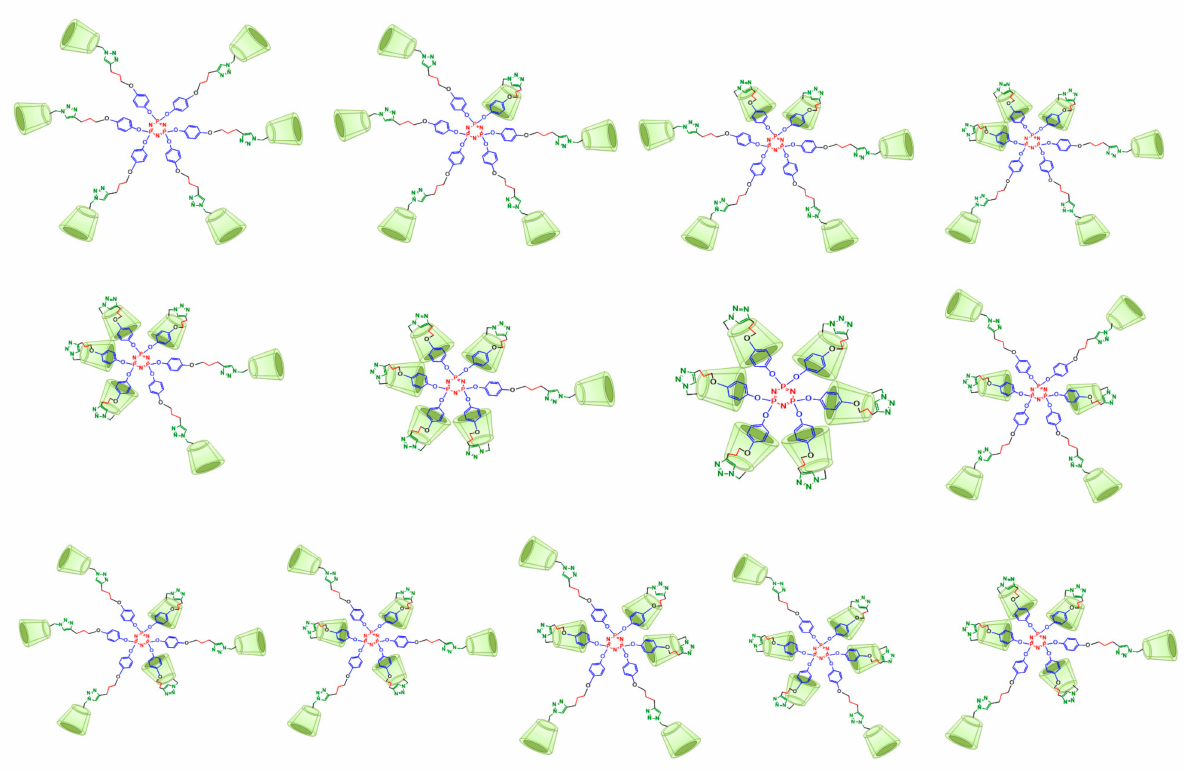
Figure 4. The 13 possible conformations for dendritic compound ( I ) with 0 to 6 inverted cavities. Similar conformations are expected for compound ( II ).